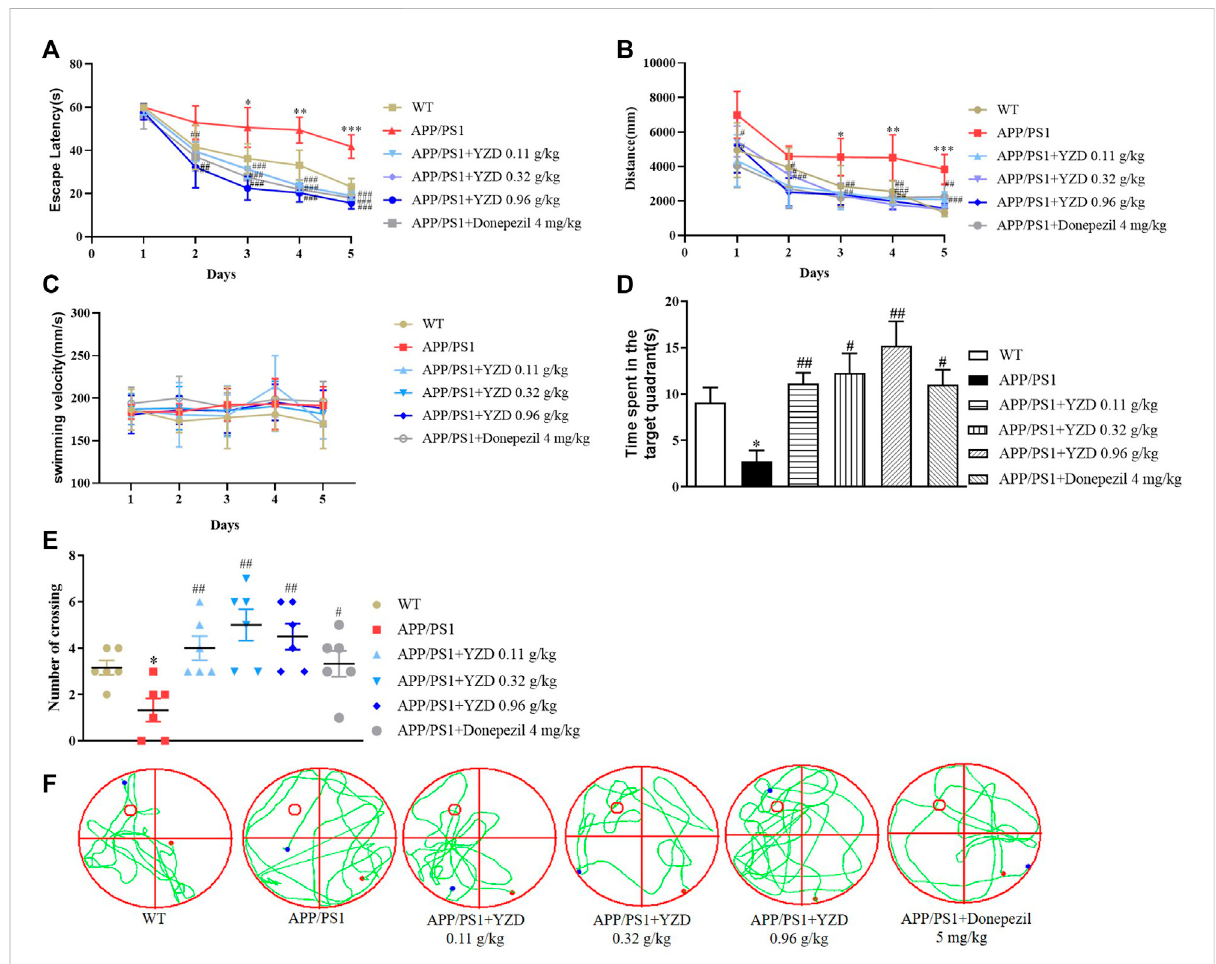
FIGURE 6 YZD administration ameliorated cognitive impairment in APP/PS1 mice. WT: wild-type mice; APP/PS1: APP/PS1 mice. (A) Swimming speed of mice in the Morris water maze. (B) Changes of escape latency of mice from the fi rst day to the fi fth dayin differentgroups. (C) Changes in swimming distance from the fi rst day to the fi fth day in different groups. (D) The time that the indicated groups of mice spent at the target area that previously contained an escape platform in the Morris water maze. (E) The times of indicated groups of mice crossing the target area that previously contained an escape platform in the Morris water maze experiment. (F) Typical swimming trajectory maps of mice passing through the platform duringthetestperiod. *p < 0.05comparedtotheWTgroup, #p < 0.05,# #p < 0.01comparedtotheAPP/PS1group.Alldataarepresentedasmean± SE ( n =